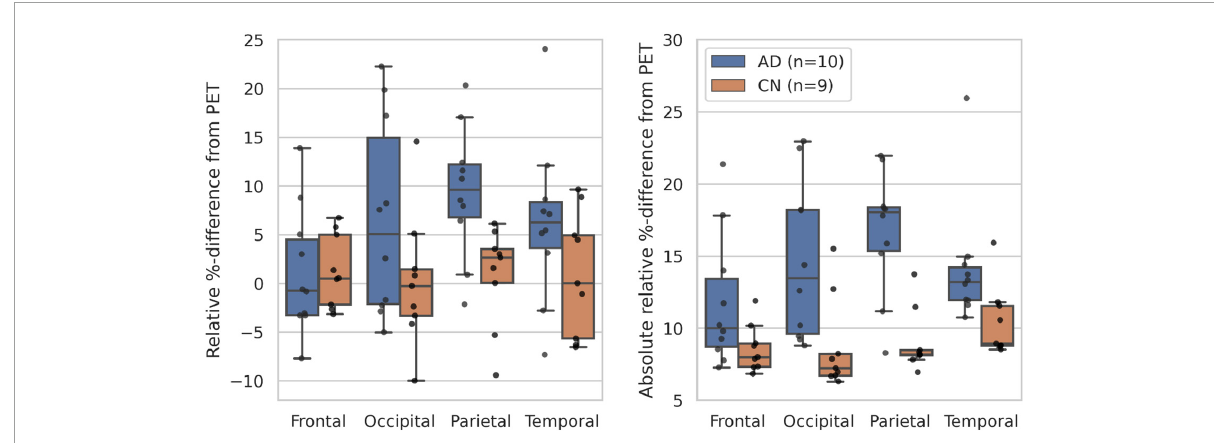
FIGURE3 Boxplots of the RD% (left) and Abs% (right) scores within selected Hammersmith brain regions for the CN ( n = 9) and AD ( n = 10) test subjects (Fonov et al., 2009; Modat et al.,